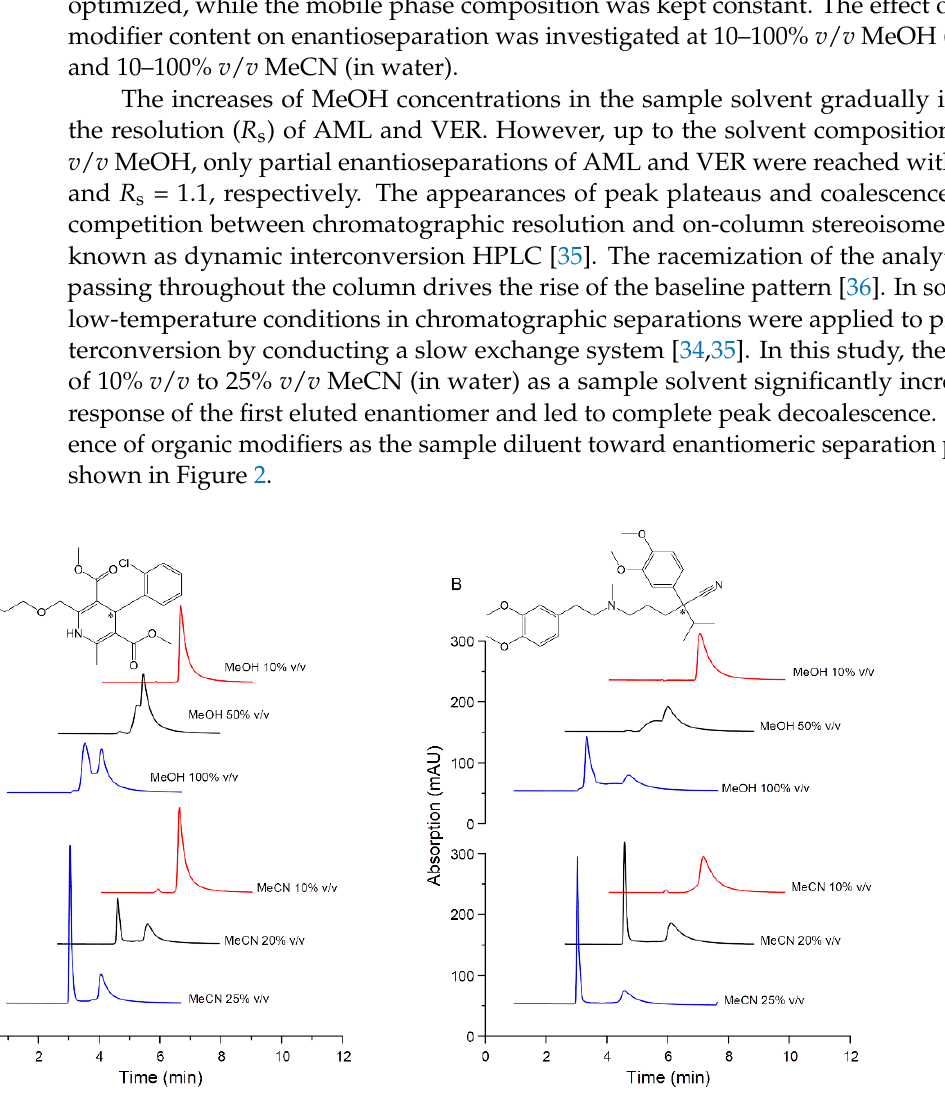
Table 1. Evaluation of CSA column. Parameter